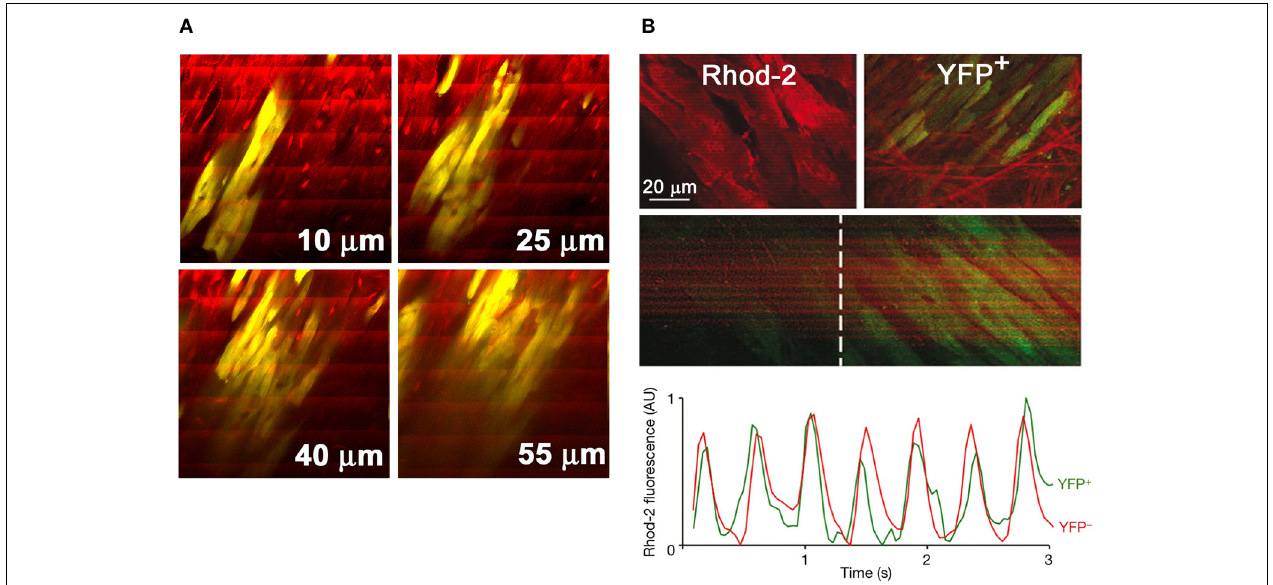
FIGURE 4 | TPLSM-based functional assessment of intracardiac cell transplants and cardiac stem cell-derived de novo cardiomyocytes in situ . (A) Series of frame-mode images acquired from a rhod-2—loaded Langendorff-perfused mouse heart bearing a graft composed of EGFP-expressing fetal ventricular cardiomyocytes (yellow due to the overlap of red rhod-2 and green EGFP fluorescence). The heart was continuously paced at 2Hz during image acquisition. Periodic increases in rhod-2 fluorescence intensity are visible as ripple-like wave fronts spanning the entire image width. Numbers in μ m denote nominal distance along the z -axis from the epicardial surface. With permission from the American Heart Association. (B) Activated Wilm’s tumor 1 (Wt1)-positive epicardial progenitors differentiate